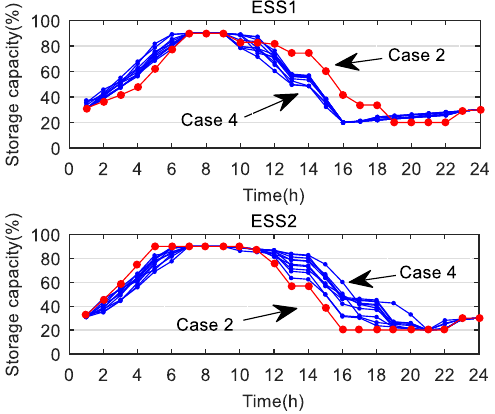
Figure 10. Storage capacity of ESS in Cases 2 and 4.